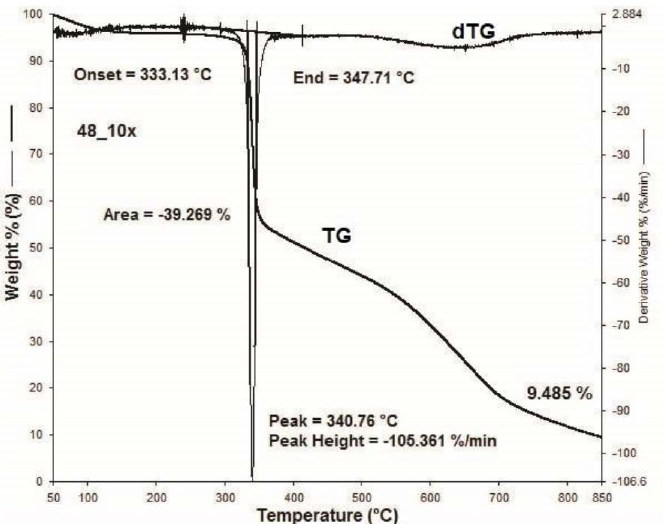
Figure 7. Thermogravimetric analysis of 48_10x sample: TG curve, dTG